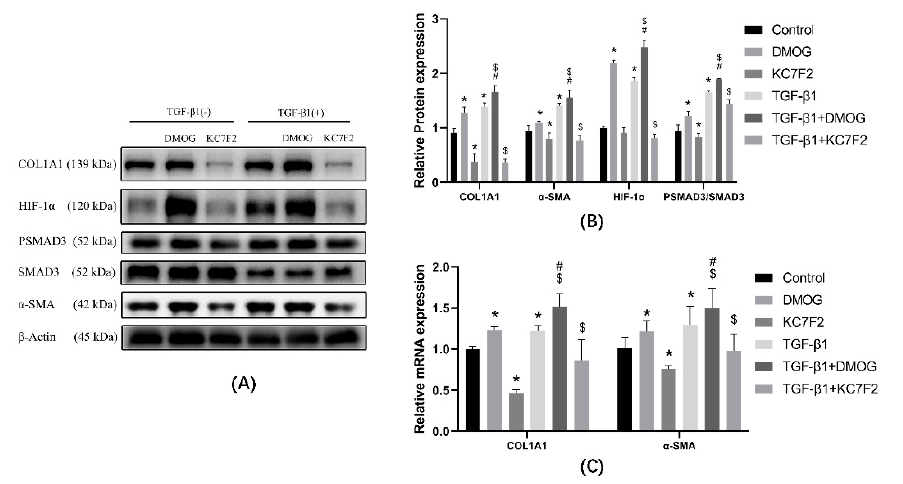
Figure 4. Cells were treated with DMSO, DMOG, and KC7F2 in the presence or absence of TGF- β 1. mRNA and protein expression were examined to infer the degree of transdifferentiation. TGF- β 1 was not present in the control group, the DMOG group, and the KC7F2 group. TGF- β 1 was present in all